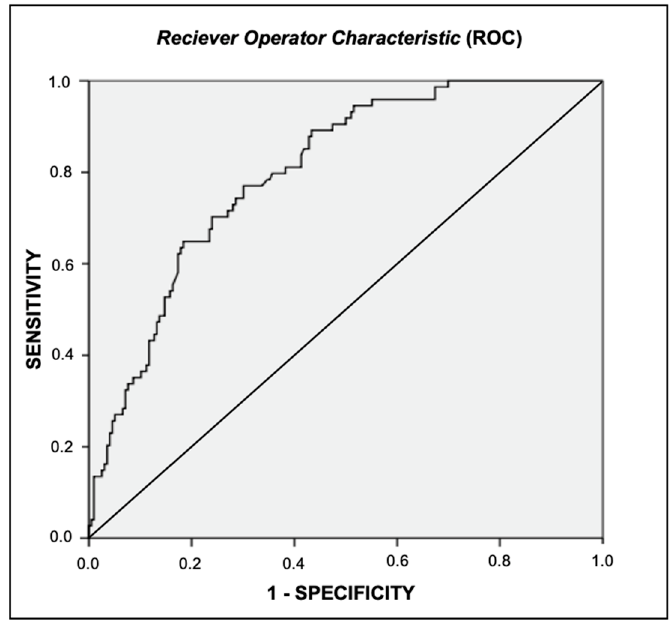
Figure 2. ROC curve for cut-off point of visceral adipose tissue associated with Metabolic